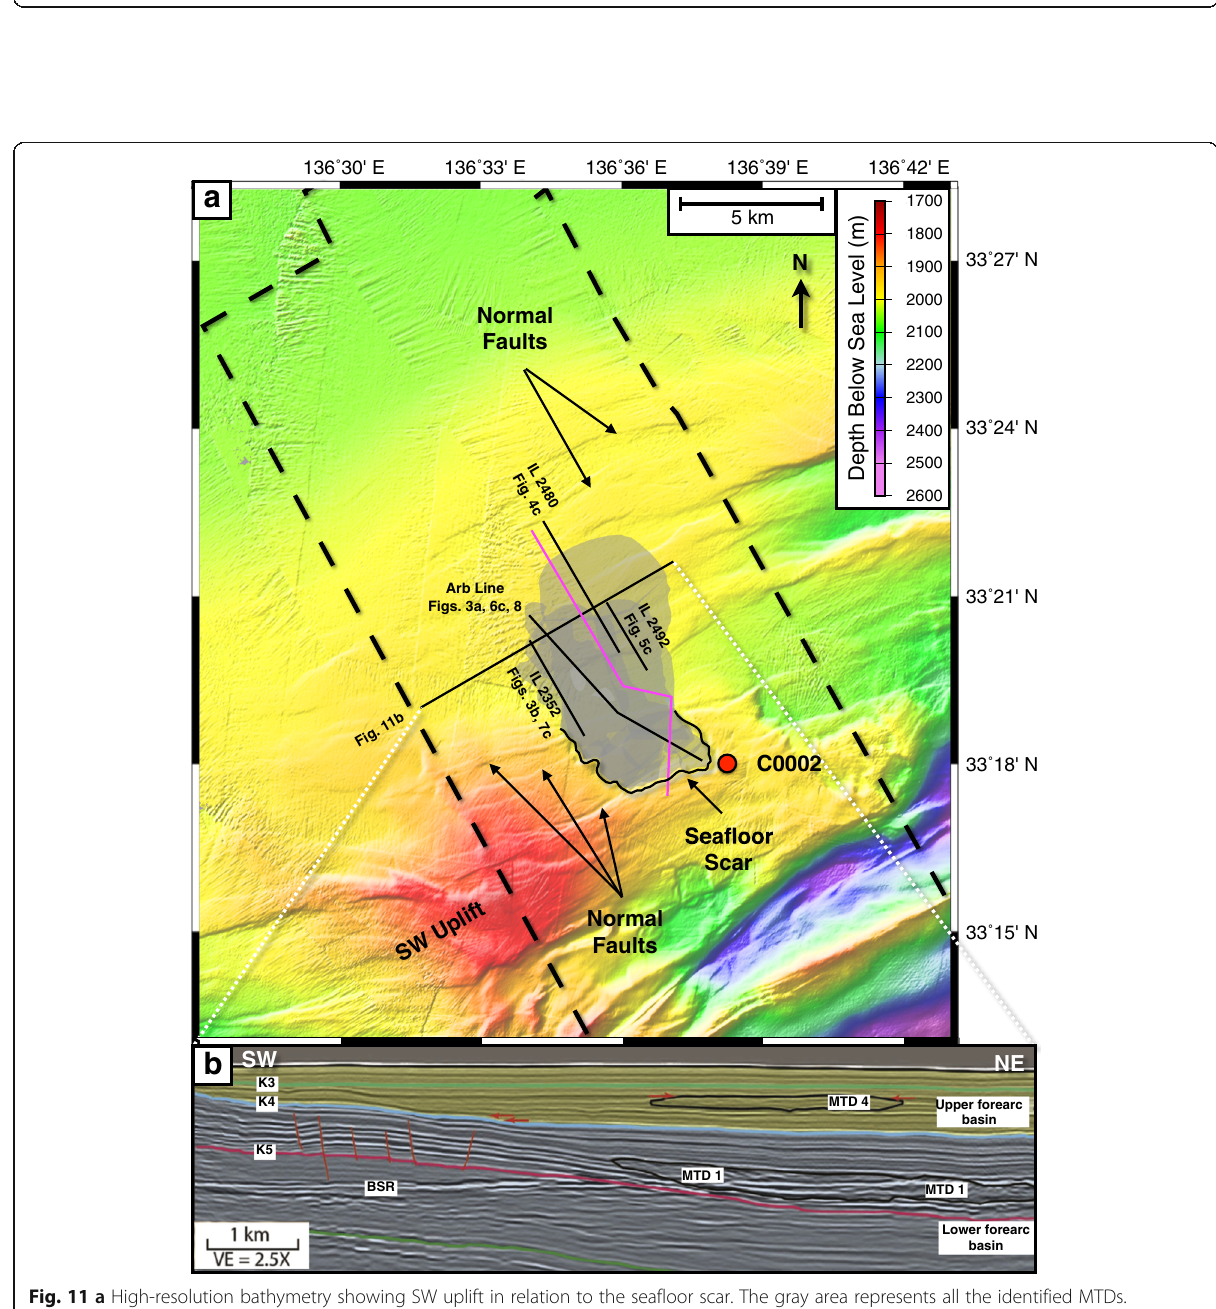
Fig. 11 a High-resolution bathymetry showing SW uplift in relation to the seafloor scar. The gray area represents all the identified MTDs. The purple line indicates the location of the Abstract figure. b Seismic cross section showing the relative stratigraphic positions of MTD 1 in the lower forearc basin stratigraphy and MTD 4 within the upper forearc basin stratigraphy. K3, K4, and K5 are upper boundaries of the Kumano Basin seismic sequences, based on toplap, downlap, onlap, or angular relations as defined by Gulick et al. (2010). BSR — bottom-simulating reflector. Modified from Moore et al.